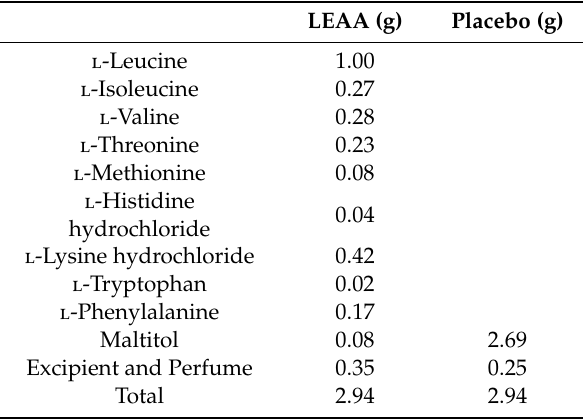
Figure 1. Schematic diagram of the experiment. Resistance exercise (RE) consists of 10 reps × three sets of leg extension and leg flexion at 70% of the one-repetition maximum. Subjects performed three sets of leg extension and then performed three sets of leg flexion. Blood sampling for the resistance exercise was taken during the switching of exercise events. Biopsies at rest and after exercise were taken from di ff erent legs. Table 2. Composition of LEAAs and placebo taken per